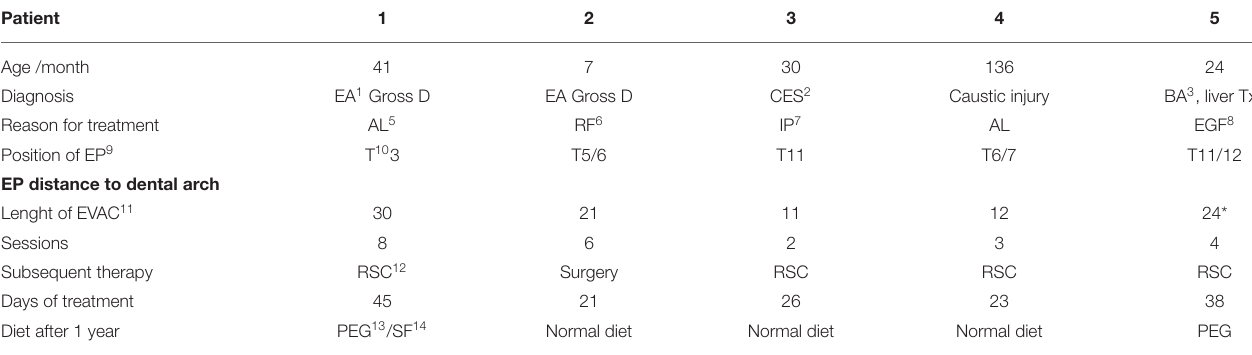
TABLE 1 | Patients treated with endoscopic esophageal vacuum-assisted closure (EVAC) between 2018 and 2020. Patient